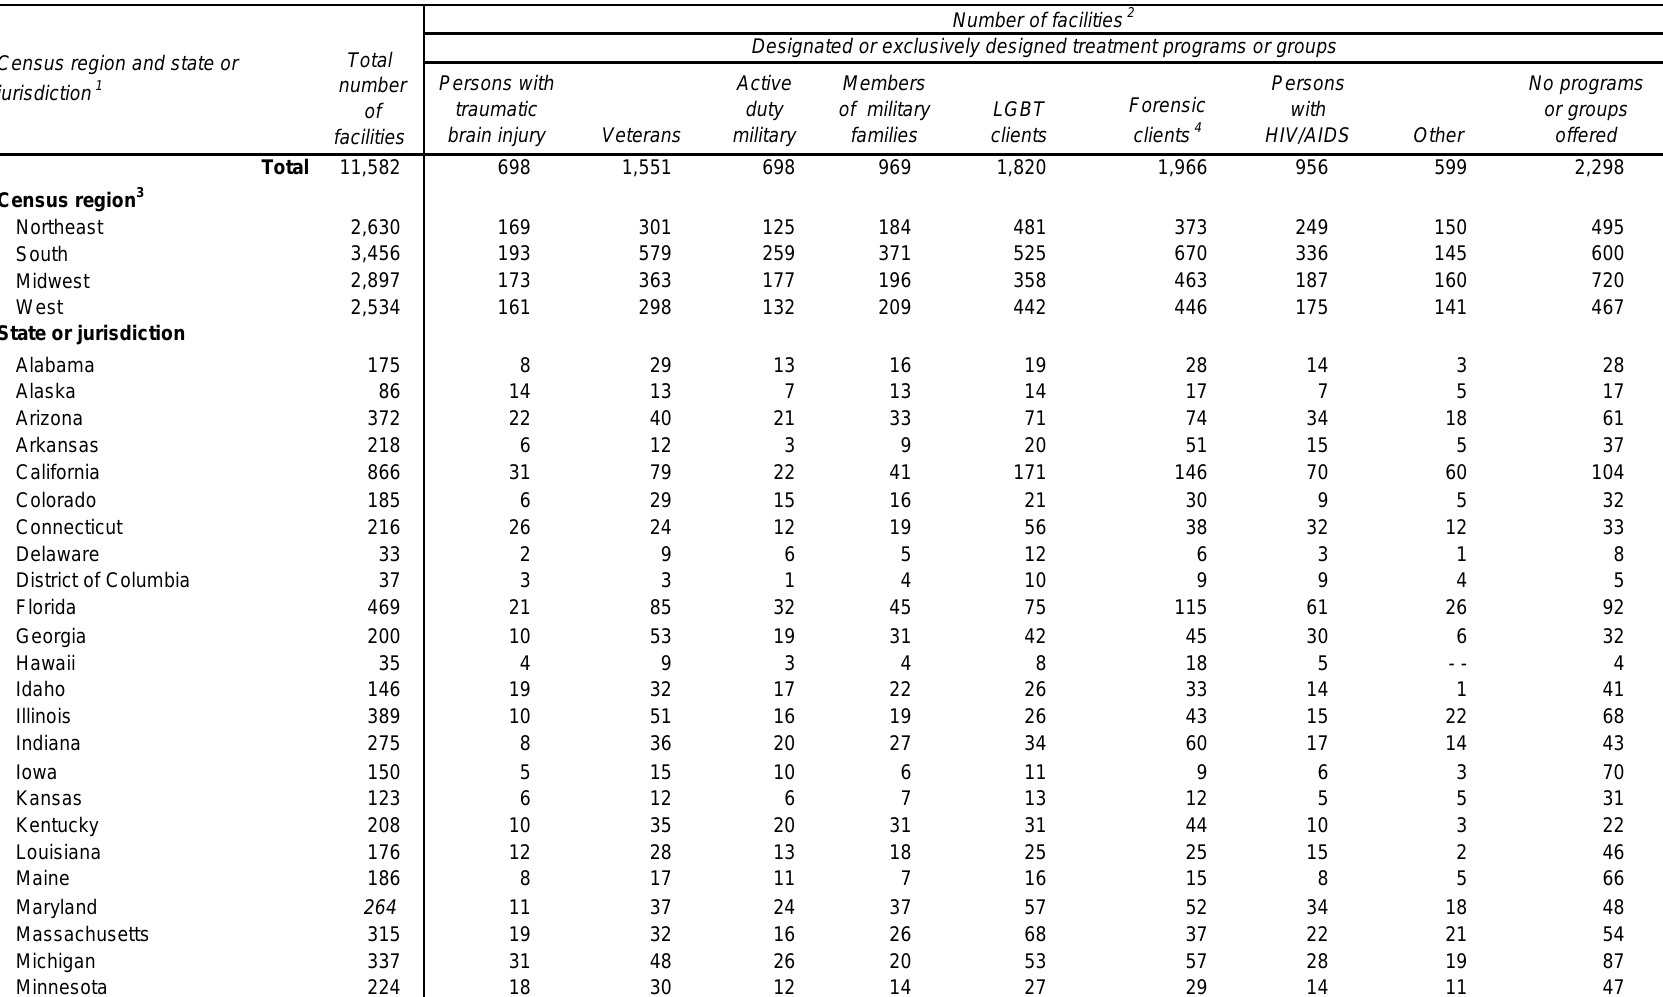
Table 3.10a. Mental health treatment facilities offering treatment programs or groups designated or designed exclusively for specific client categories,